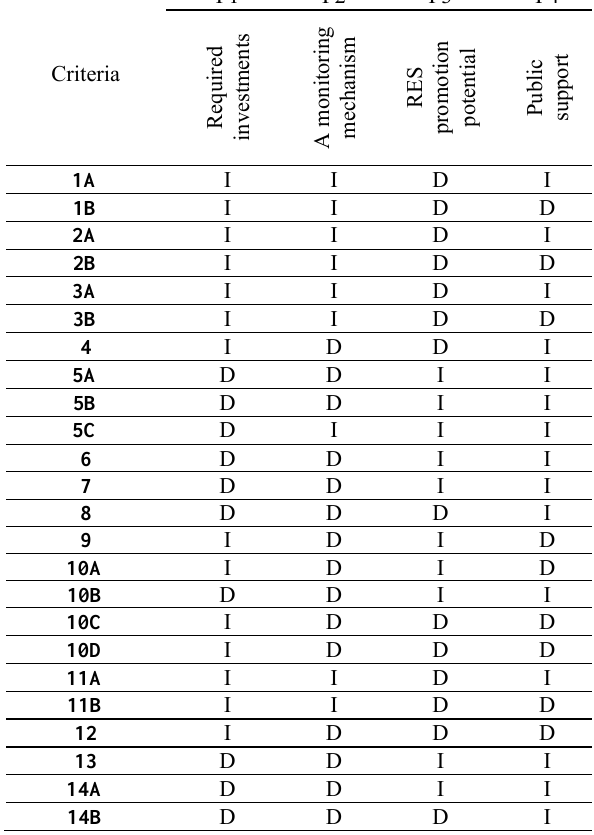
*Increases – I; Decreases –